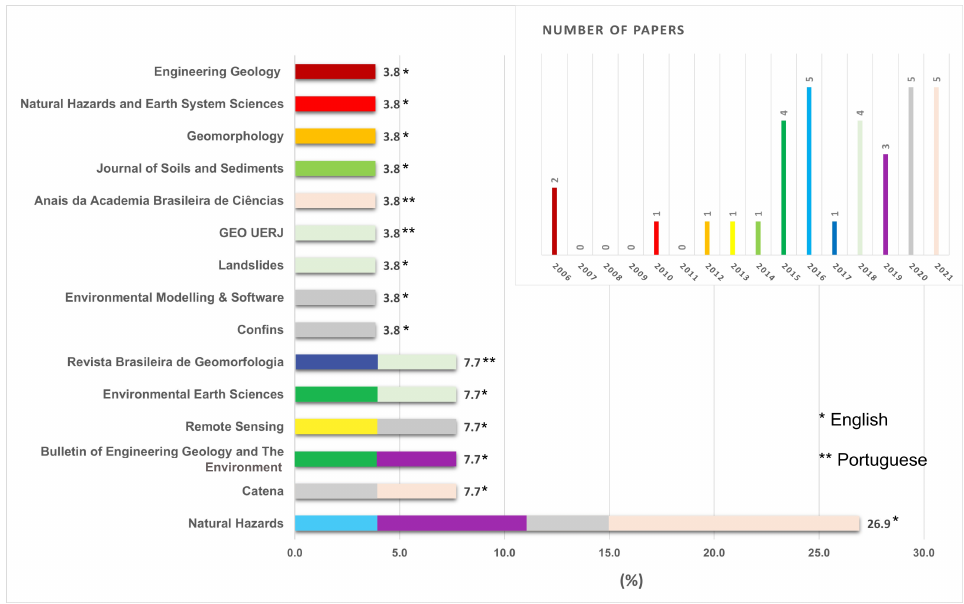
Figure 5. Journals with publications related to susceptibility assessments in Brazil and their year of